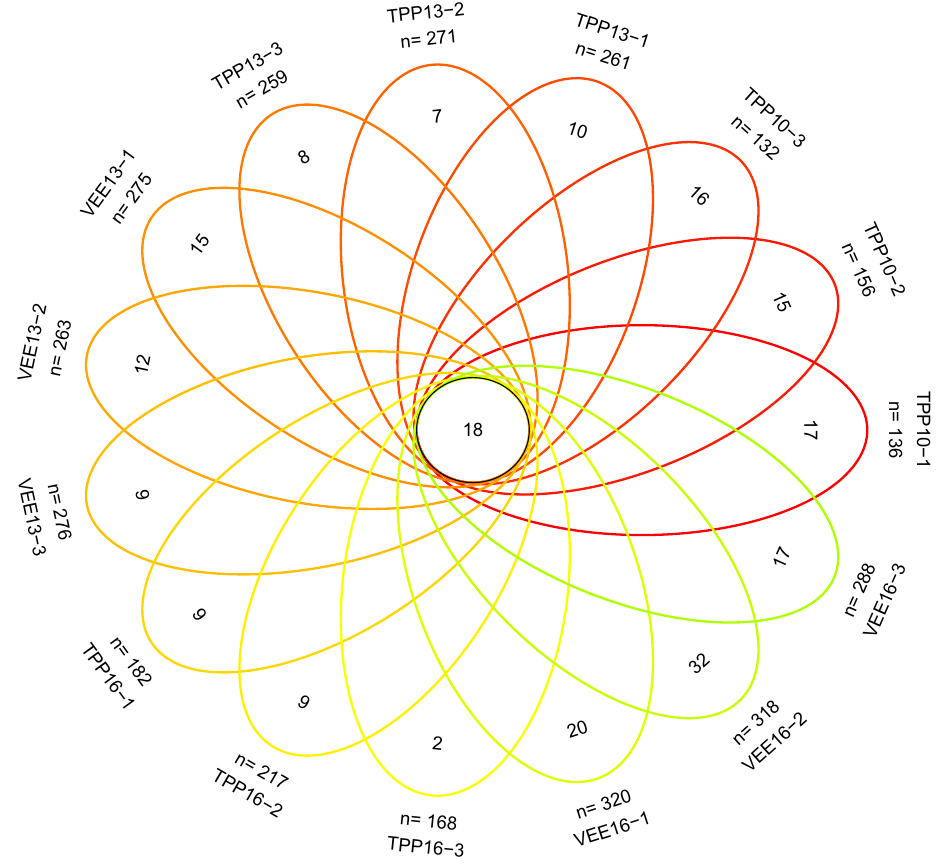
Figure 2. Venn diagram of the number of common and unique operational taxonomic units (OTUs). The number in the circle of petal graph represents the number of similar OTUs among samples, and the number after n represents the number of OTUs contained in a sample